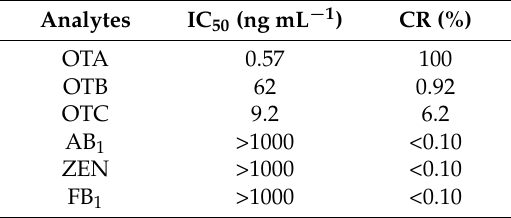
Table 2. Cross-reactivity of Nb28-AP with OTA structural analogs and other